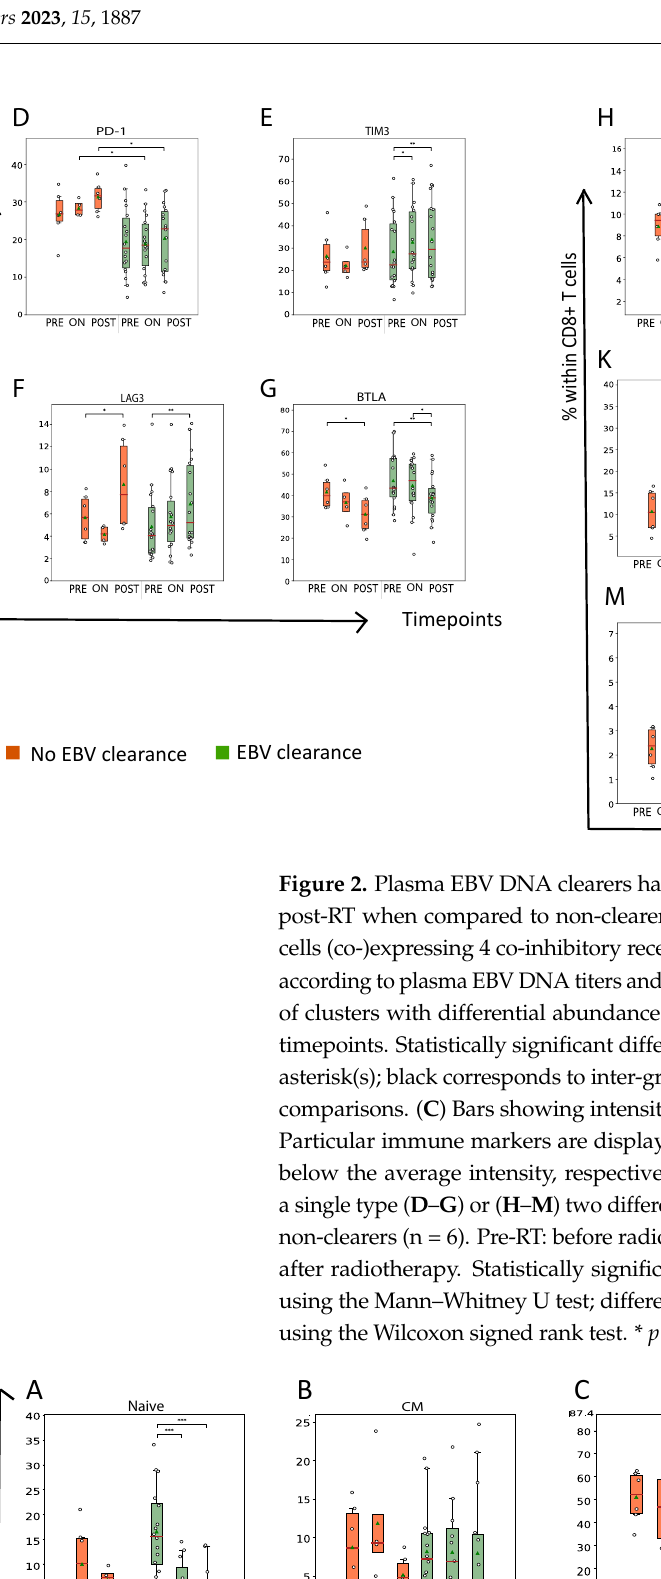
P r e R T O n R T P o s t R T